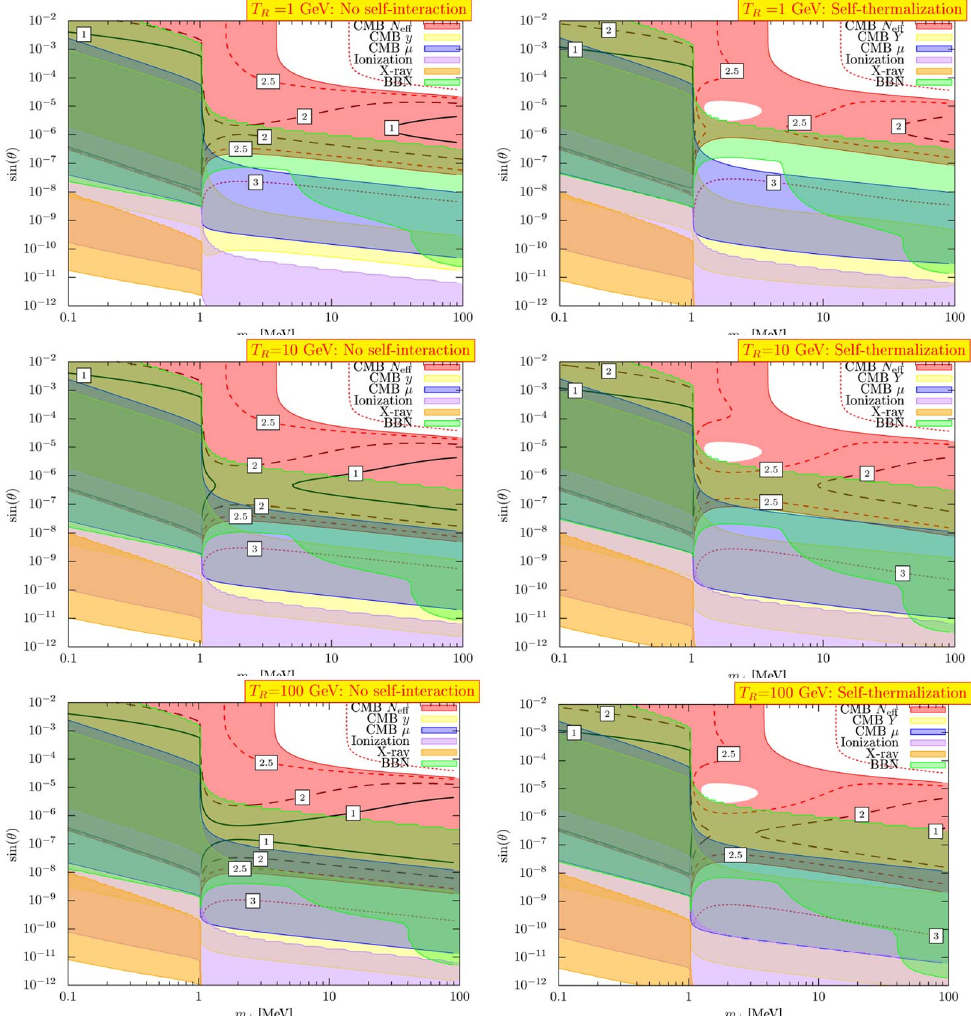
Figure 17. Cosmological constraints on the dark scalar for different reheating temperatures. The red, yellow and blue regions correspond to the constraints by the CMB measurement of the N eff , y -distortion and µ -distortion, respectively. The light purple region is excluded by ionization after the recombination era. The orange region is excluded by the X-ray constraints on the decaying dark matter. We also show the BBN constraints as the green shaded